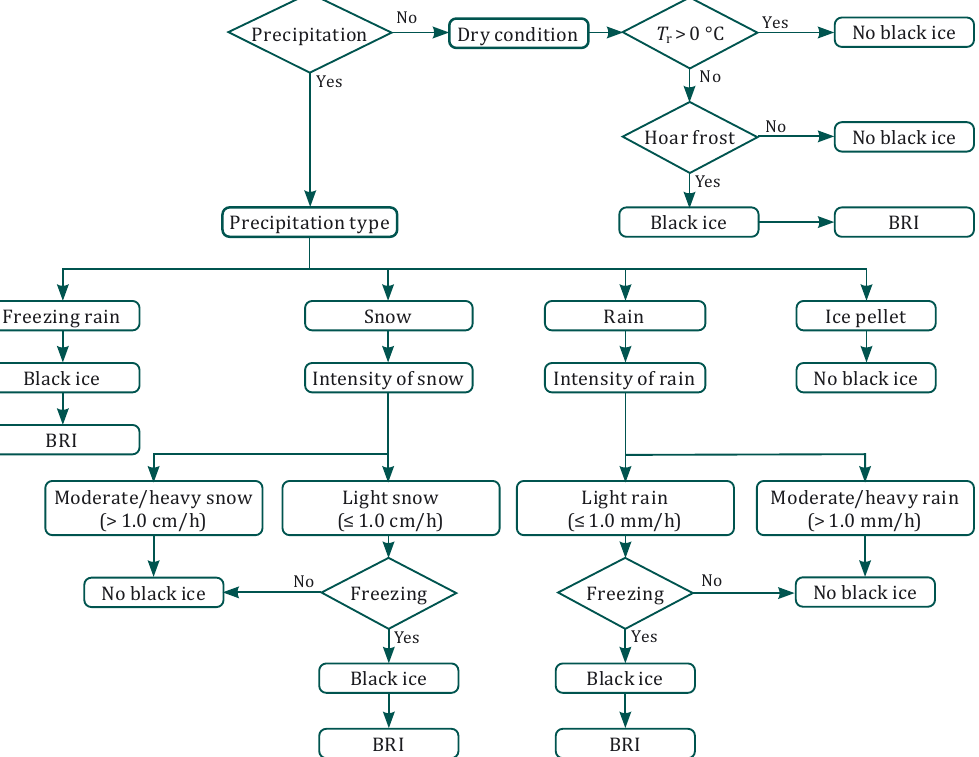
Figure 1. Algorithm of black ice prediction model